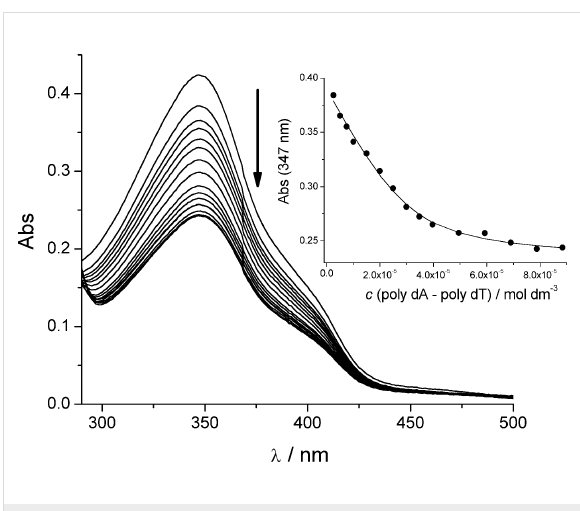
Figure 1: Changes in the UV–vis spectrum of AP3am ( c = 1.0 × 10 − 5 mol dm − 3 ) upon titration with poly dA–poly dT; Inset: dependence of the AP3am absorbance at λ max = 347 nm on c (poly dA–poly dT), pH 7.0, sodium cacodylate buffer, I = 0.05 mol dm − 3